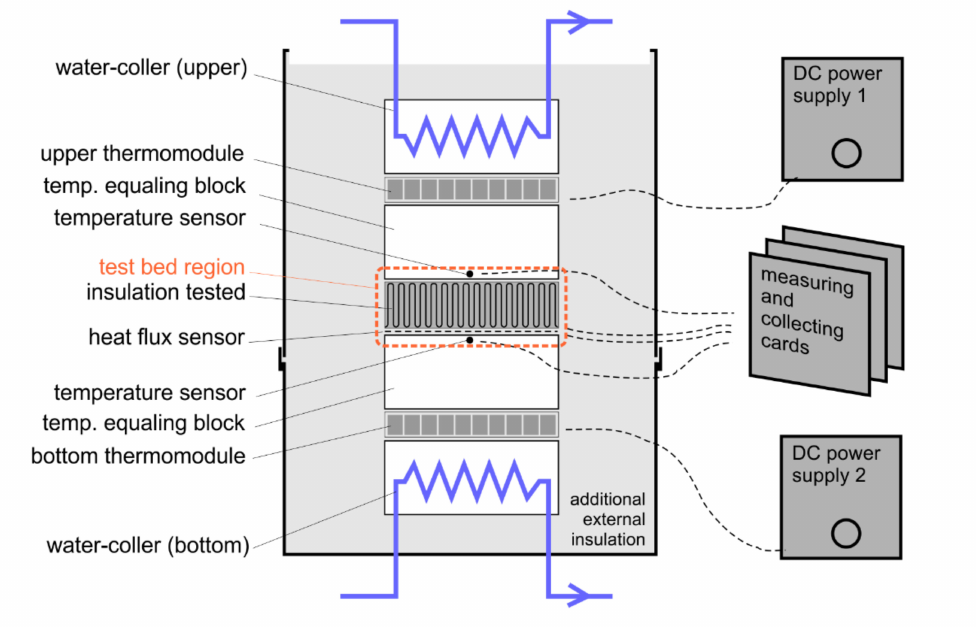
Figure 6. Schematic diagram of the thermoelectric version of the hot plate apparatus applied for experimental